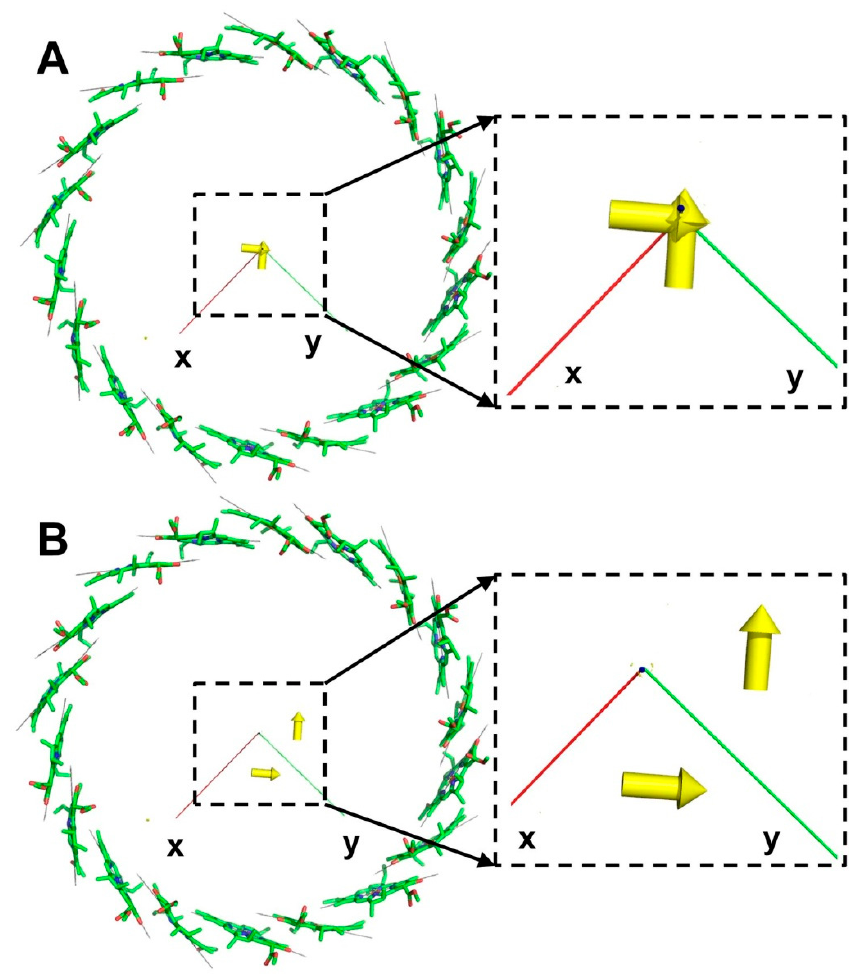
Figure 4. B850 exciton transition moments D µ (yellow arrows) calculated for the isoenergetic ( A ) exciton Hamiltonian and for the Hamiltonian ( B ) with site energies, taken from [57].